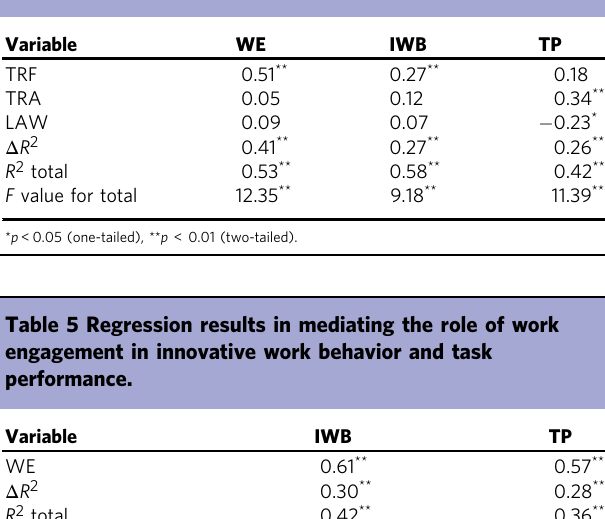
Table 4 Regression results in impacts of leadership styles on work engagement, innovative work behavior, task performance.